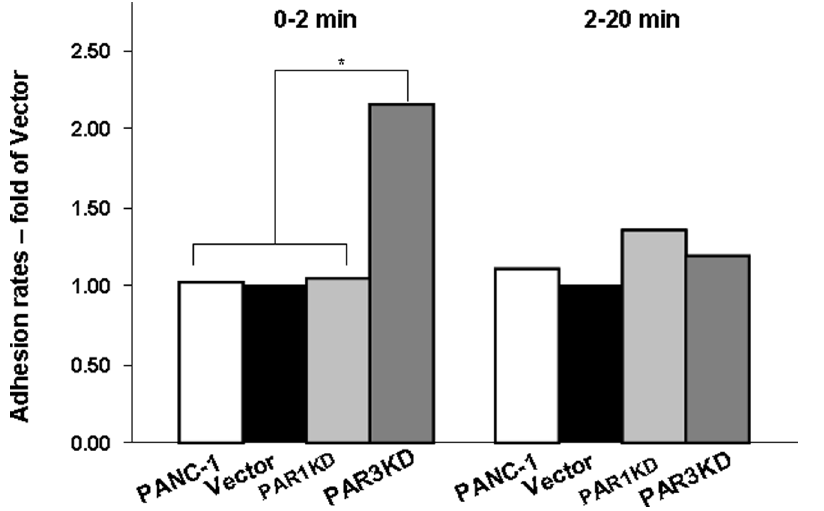
Figure 2. Increased adhesion of PAR-3 KD cells due to initial rate. Experiments were performed as described in Legend to Fig. 1B. The bars represent ratios of 0 to 2 min or 2 to 20 min adhesion rate values of the indicated PANC-1 variants to those of vector-control cells. The data are presented as ratios of averages obtained from four independent experiments. * denotes p , 0.02, all other differences not significant.